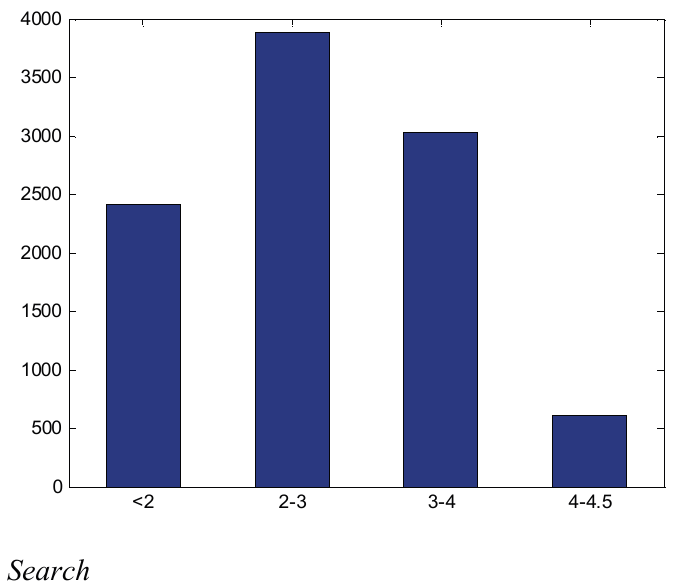
Figure 3. Histogram of the brightest star’s magnitude